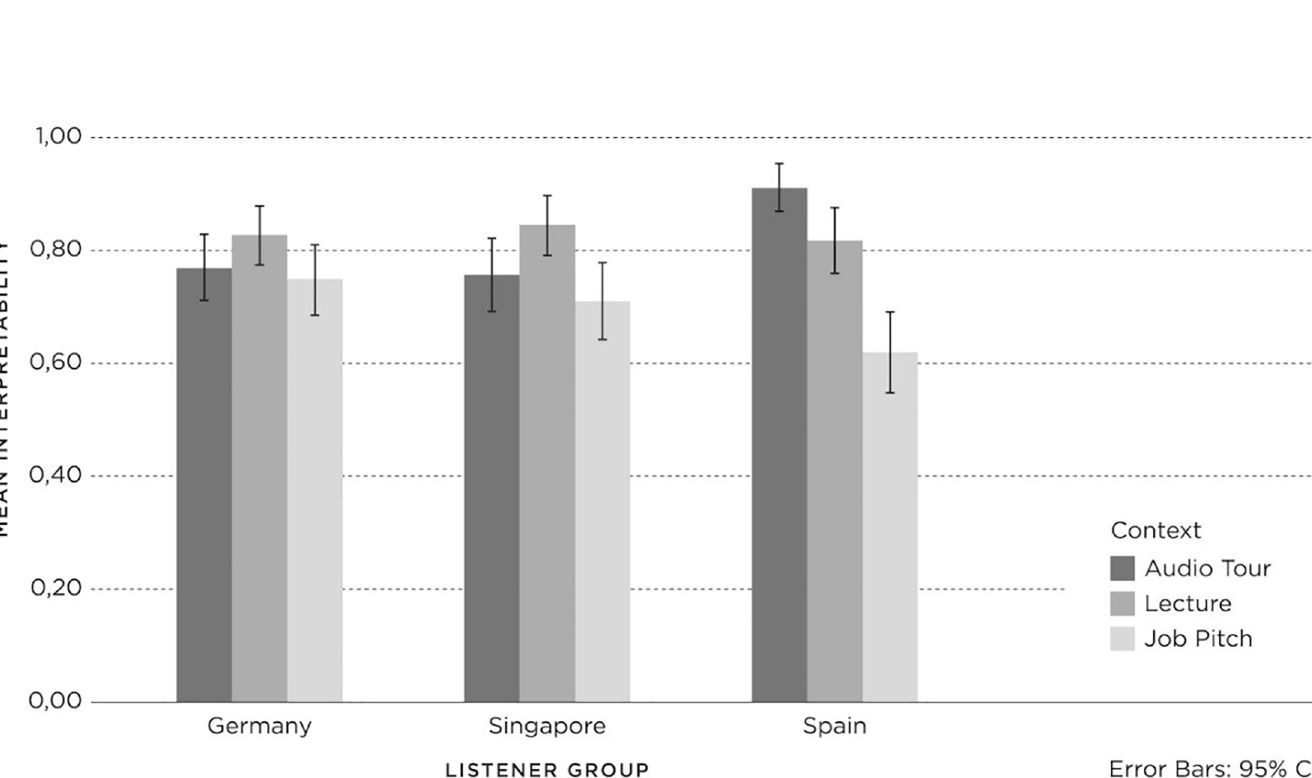
PLOS ONE | https://doi.org/10.1371/journal.pone.0231089 April 29, 2020 17 /